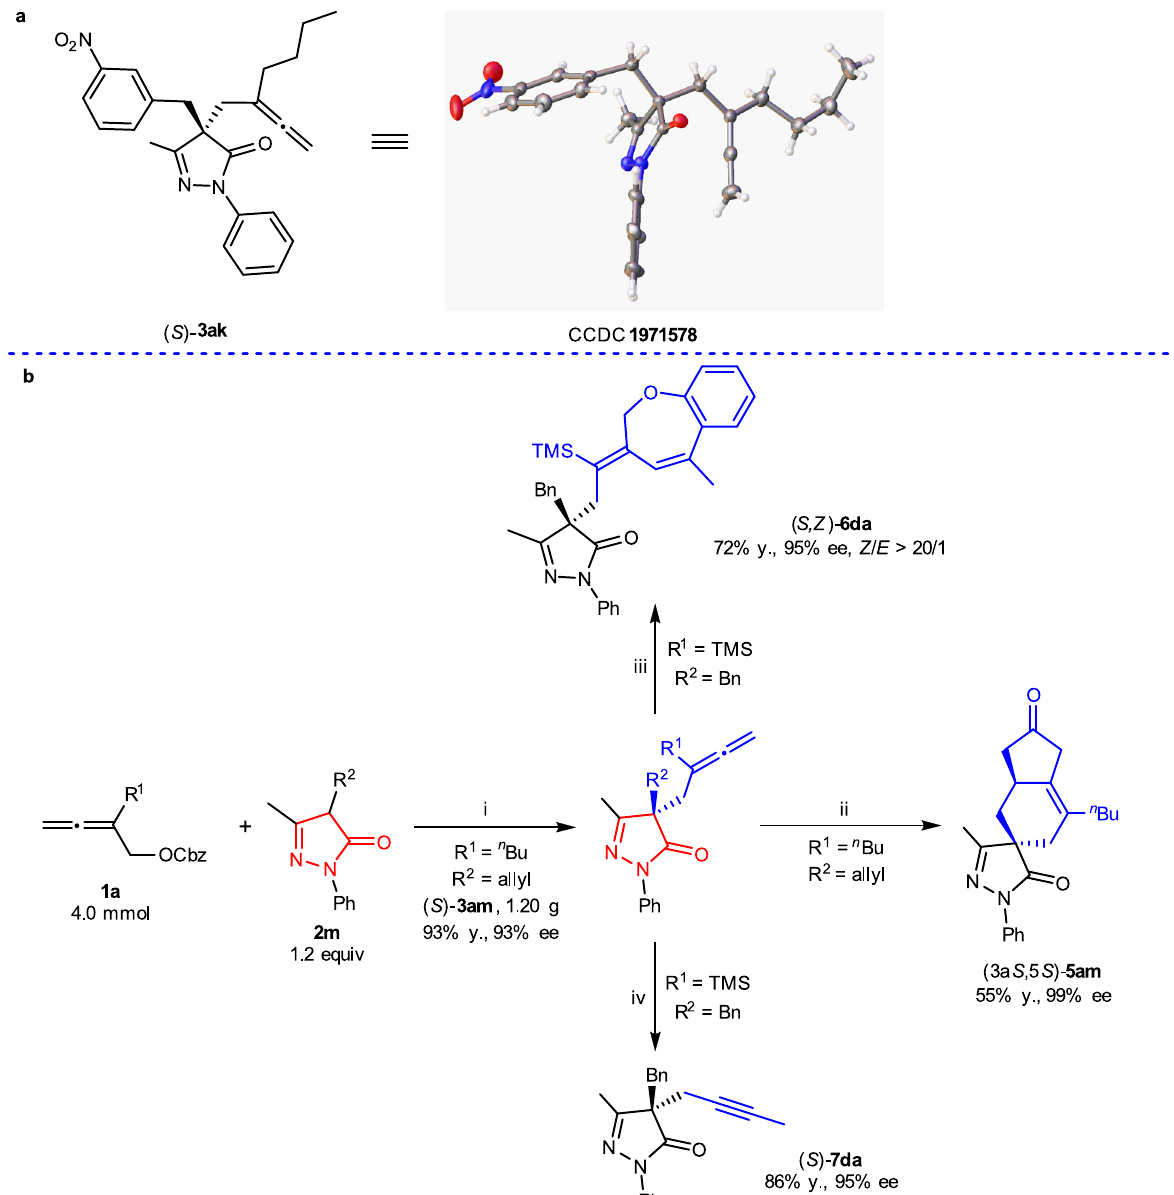
Fig. 4 ORTEP representation and sythetic applications. a ORTEP representation of ( S )- 3ak . b The gram-scale reaction and applications: reaction conditions: (i) Pd 2 (dba) 3 (cid:129) CHCl 3 (2.5 mol%), DACH-ZYC-Phos-C1 (5.0 mol%), toluene, 60 °C, 13 h; (ii) [Rh(CO) 2 Cl] 2 (5.0 mol%), AgSbF 6 (12.5 mol%), CO balloon, toluene, 50 °C, 13 h; (iii) ortho-(propen-2-yl)phenol (3.0 equiv), Pd(OAc) 2 (7.5 mol%), 2,2 ’ -bipy (7.5 mol%), Cu(OAc) 2 (cid:129) H 2 O (0.5 equiv), toluene, 110 °C, 18 h; (iv) TiCl 4 (1.5 equiv), dichloromethane, − 78 °C, 2.5 h, rt, 5.5 h. TMS trimethylsilyl, Cbz benzyloxycarbonyl, y. isolated